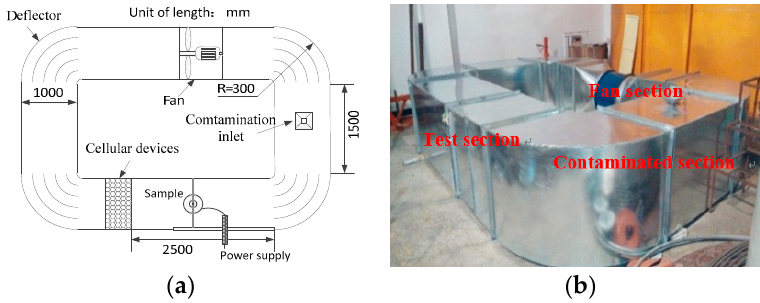
Figure 6. Wind tunnel test device. ( a ) Diagram of wind tunnel; ( b ) Wind tunnel.